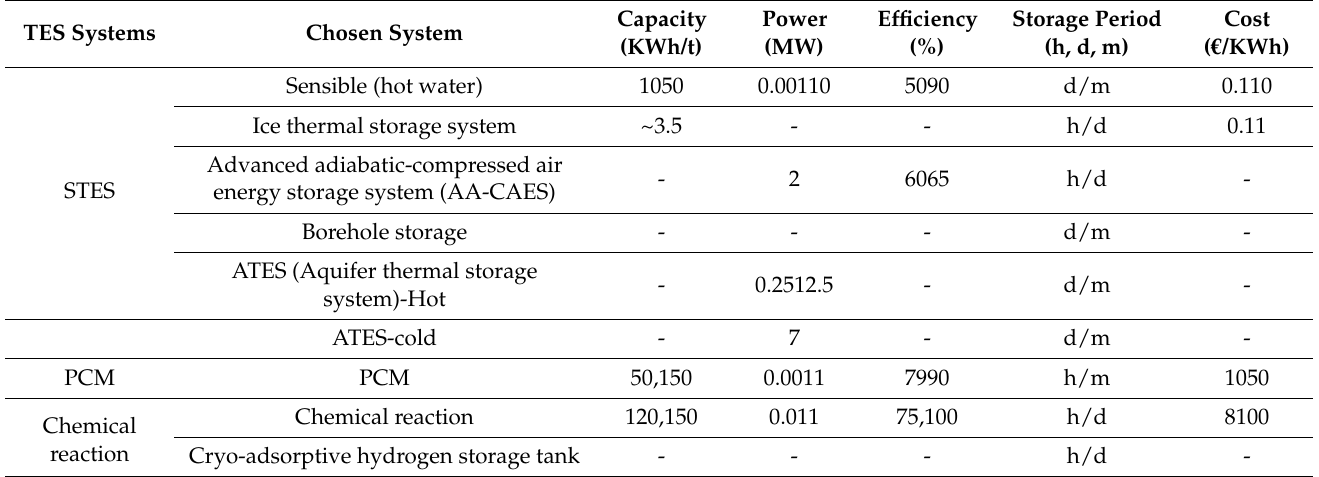
Table 2. Thermal storage system typical parameters (compiled from